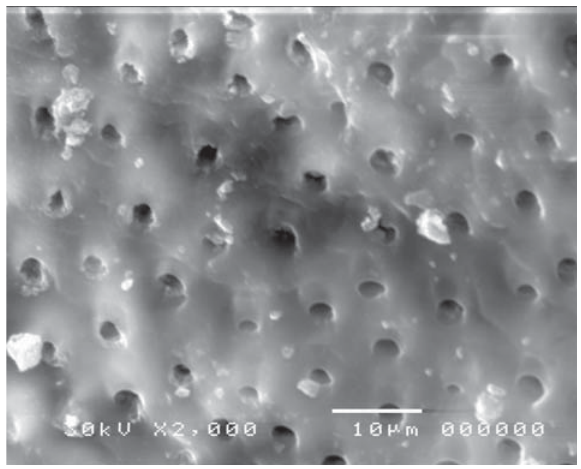
to conventional high speed turbine bur after acid etching where the smear layer was removed and the dentinal tubules were obvious. The intertubular dentine appears more ablated than the peritubular one (x2,000)